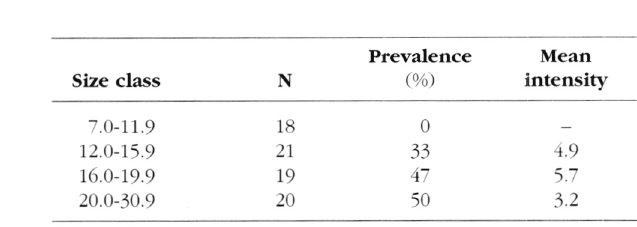
Table I. - Prevalence and intensity of the large metacercariae in the thoracic ganglion of Pachygrapsus marmoratus at Sao Torpes, Por­